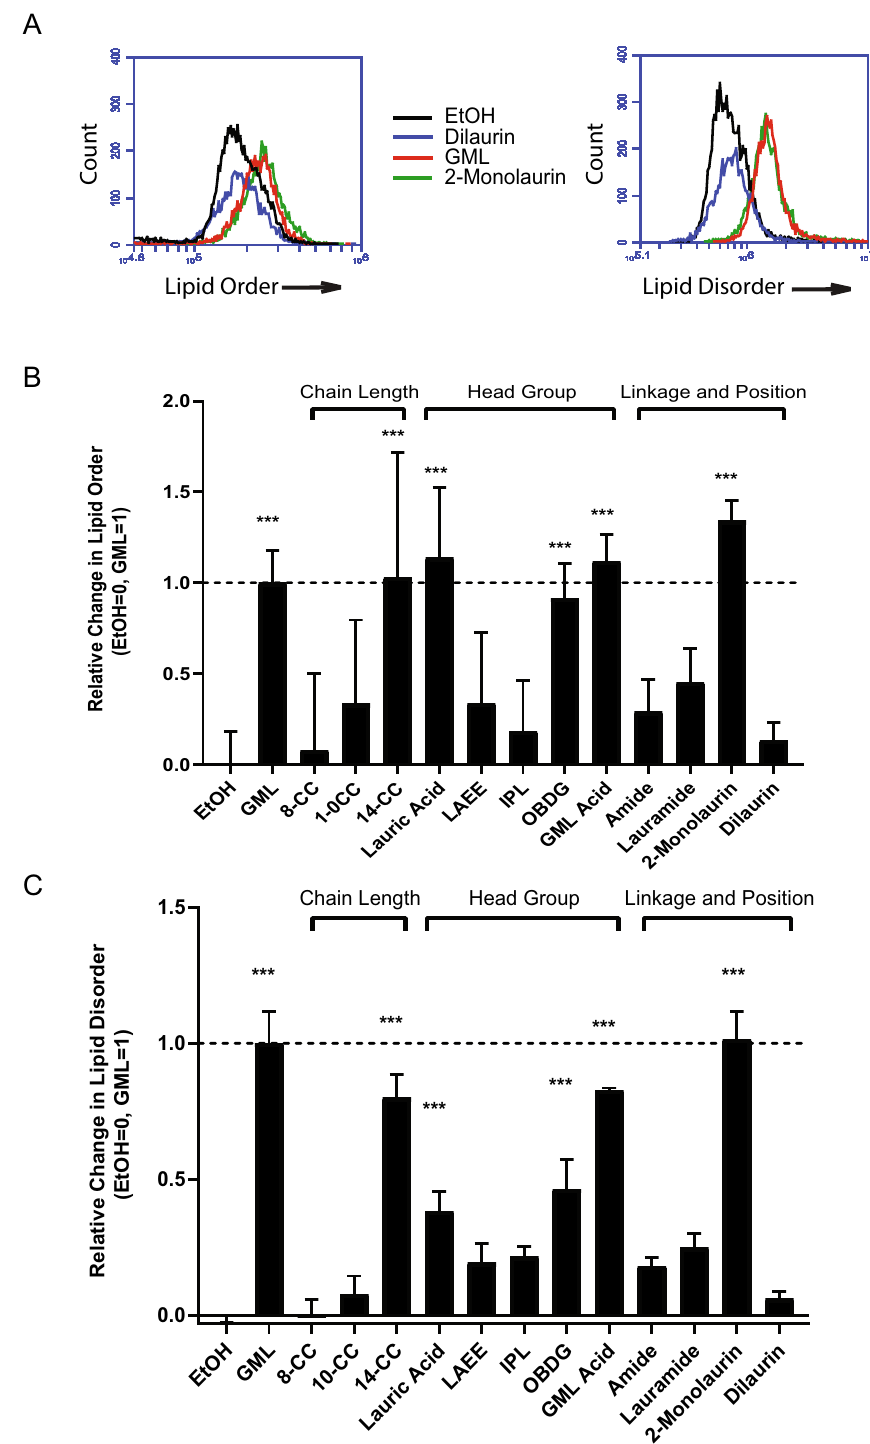
Figure 3. Changes in chain length, head group polarity, and linkage affect lipid membrane dynamics. APBT were treated with 10 ug/mL of designated compounds, stained with Di-4ANEPPDHQ , and analyzed on an Accuri C6 flow cytometer. Representative figures from data collection are presented with “Ordered” membrane and “disordered” membrane were analyzed using different fluorescent channels ( A ). Quantified relative change in “Lipid Order” ( B ) and “Lipid Disorder” ( C ) is compiled from 3 independent experiments with distinct donors and is presented as a fold change on a range of 0 to1, with EtOH set to 0 and GML set to 1. Statistical significance was determined using a Repeated Measures One-Way ANOVA. (* p < 0.05, ** p < 0.01, *** p <